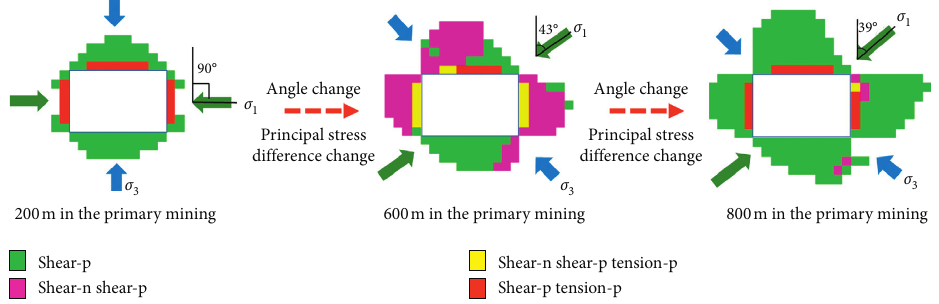
Figure 14: The shape of plastic zone changes when the coal-mining face is mined to 400m, 600m, and 800m under the condition of the primary mining under the background of the